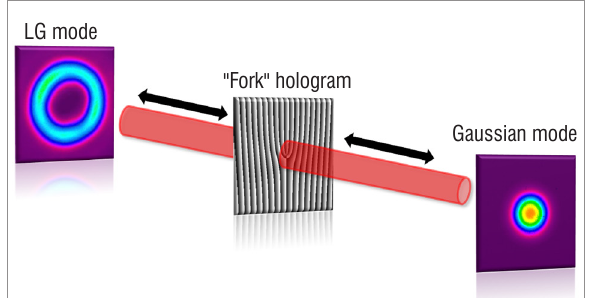
Figure 4: A spatial light modulator encoded with azimuthal phase depend ence, exp( i ℓ ϕ ) , shapes a Gaussian beam into a helically phased beam in the first diffraction order. This process also works in reverse, such that an Laguerre–Gaussian (LG) beam can be converted into a Gaussian beam.